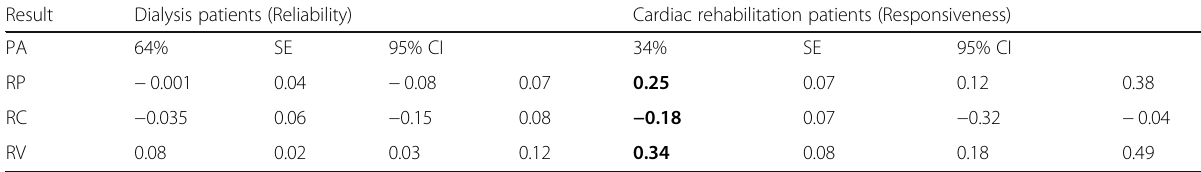
Table 6 Evaluation of change in the Health change item using Svensson ’ s method for the patient groups Result Dialysis patients (Reliability) Cardiac rehabilitation patients (Responsiveness)